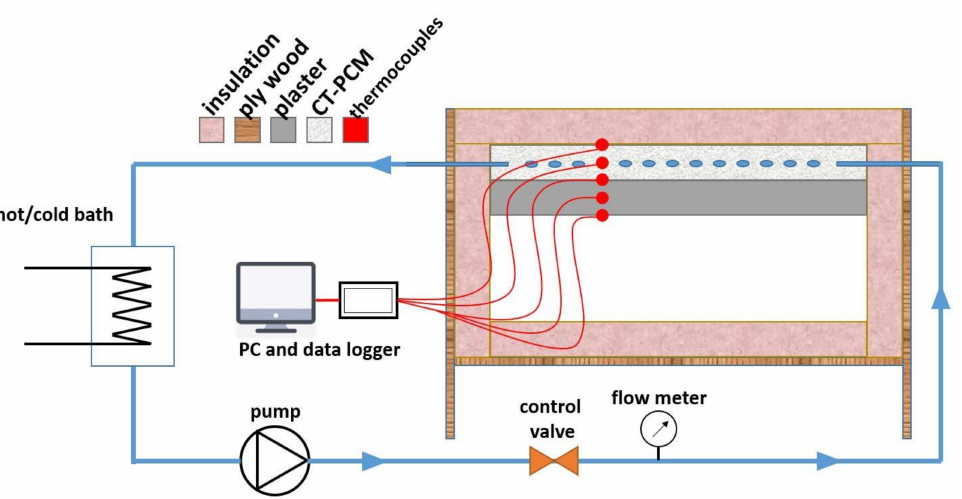
Figure 7. Thermally activated roof testing equipment